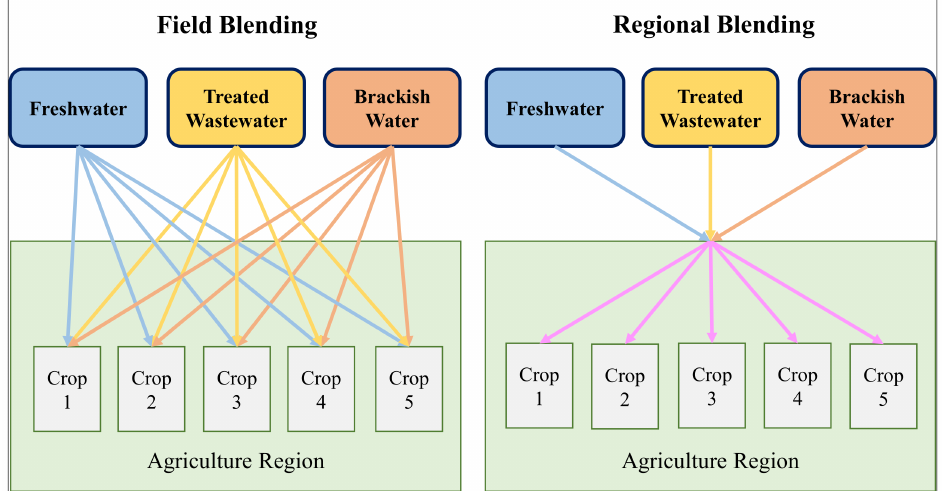
Figure 1. Schematic illustration of the field and regional blending scenarios in an agricultural region with five crops that can be irrigated by three water sources with different salinity levels: freshwater, treated wastewater, and brackish